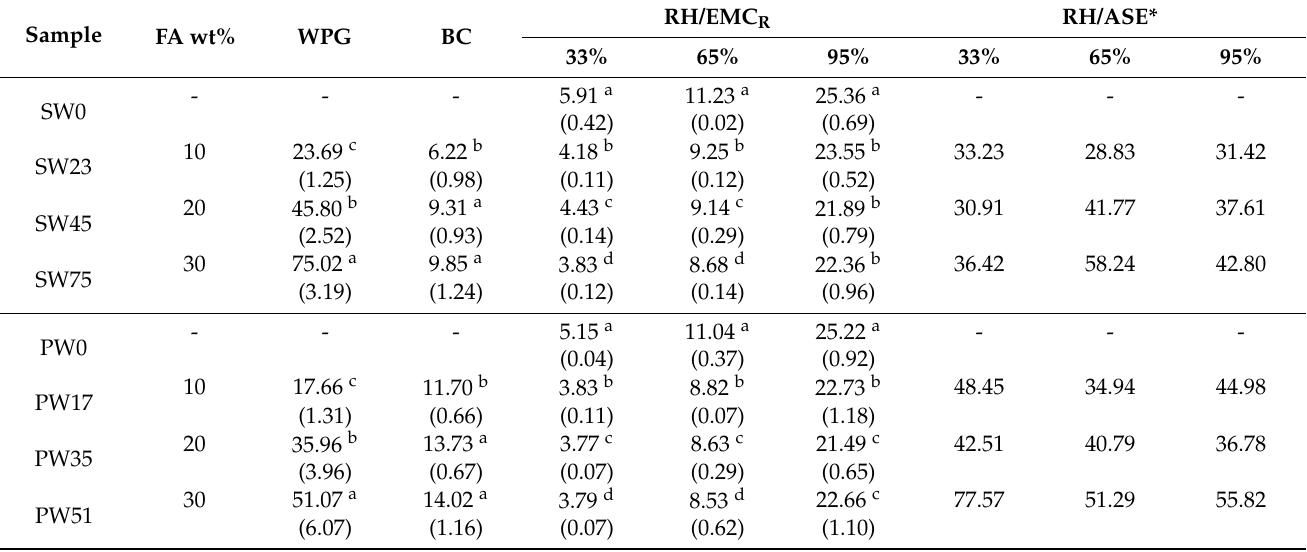
Table 1. WPG and BC and variations in EMC R and ASE* at 20 ◦ C for Chinese fir and poplar wood with furfurylation